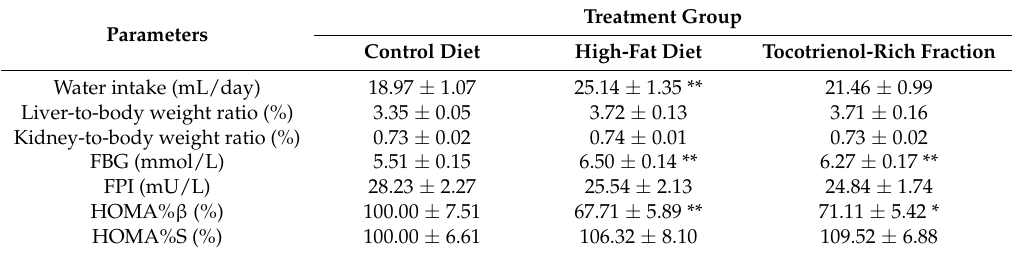
Table 3. Food and water intake, organ weight, and glycemic indices of the rats given the control diet, the high-fat diet, and the TRF at the end of the eight-week treatment.